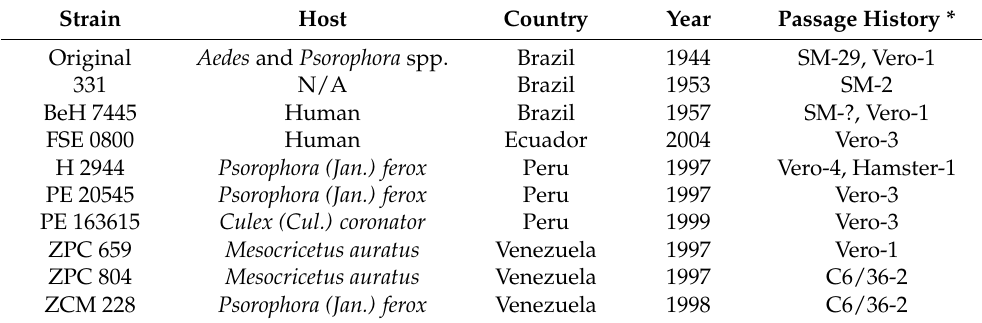
Table 1. History of Ilheus strains utilized in this